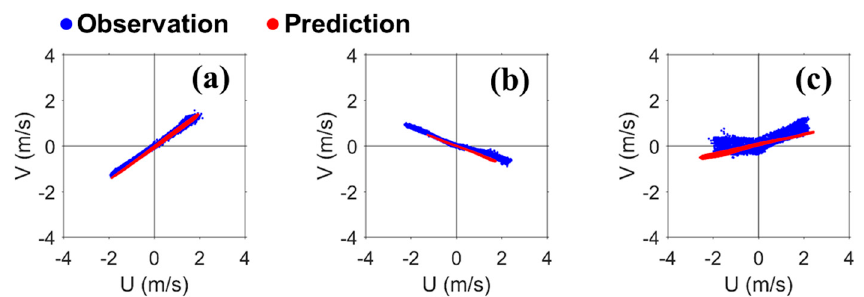
Figure 6. Scatterplots of U and V velocity components for model-predicted depth-averaged tidal currents and NOAA observations at three Year 2012 ADCP survey stations located in the upper Cook Inlet ( a ) COI1210; ( b ) COI1207; ( c ) COI1209. The plots were generated from depth-averaged velocity time series for both model predictions and field observations.